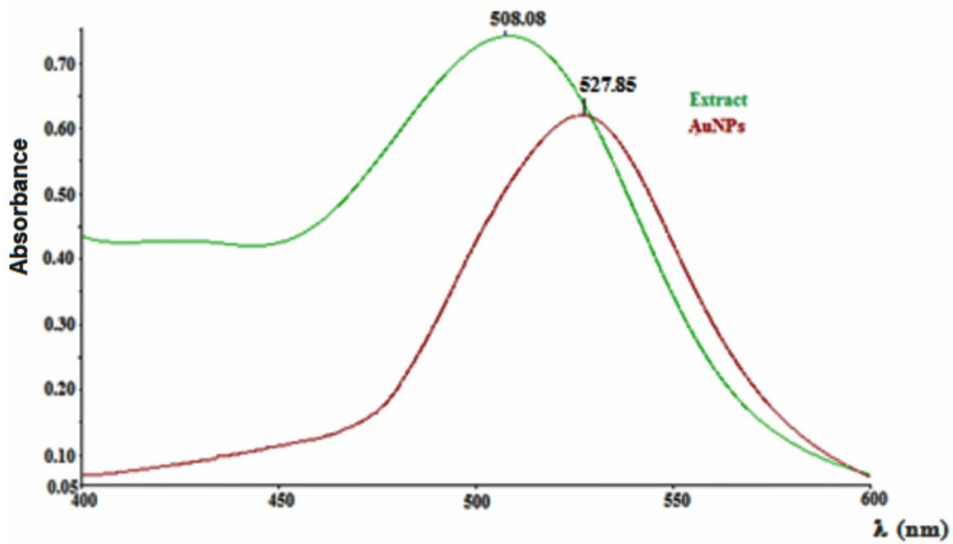
Figure 2. UV-Vis spectra of Cornus mas L. extract and gold nanoparticles. The TEM image of the obtained gold nanoparticles revealed their shape and morphol- ogy as well as their size. The functionalized AuNPs were spherical in shape, dispersed and presented a mean diameter of 19 nm (Figure 3).